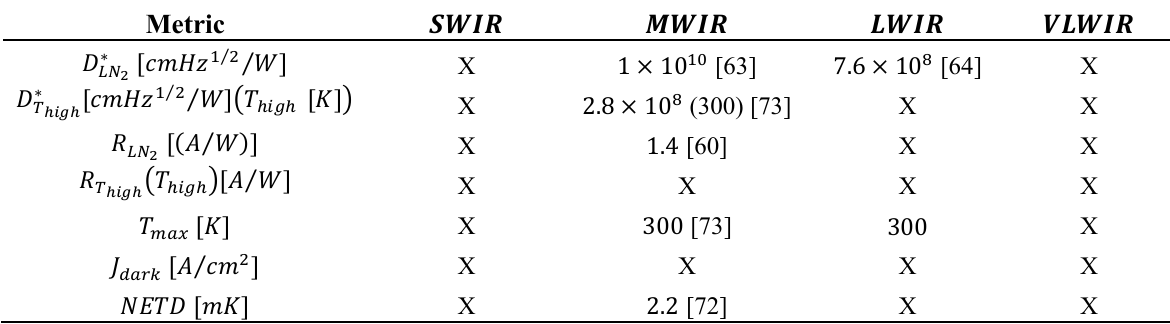
Table 2. Highest reported performance metrics for InSb IRPDs across different wavelength regimes. Metric